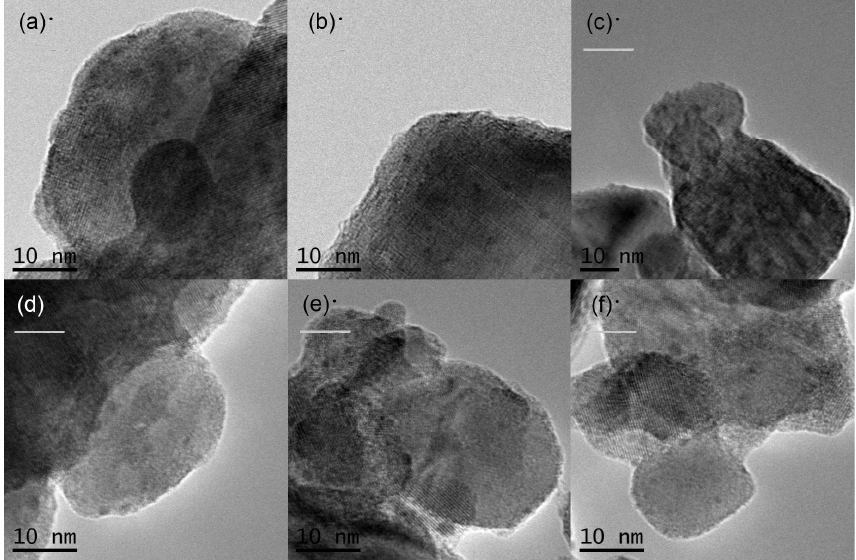
Figure 5. TEM images of Pt/KTa(Zr)O 3 modified with (a) Dye 1, (b) Dye 2, (c) Dye 3, (d) Dye 4, (e) Dye 5 and (f) Dye 6.